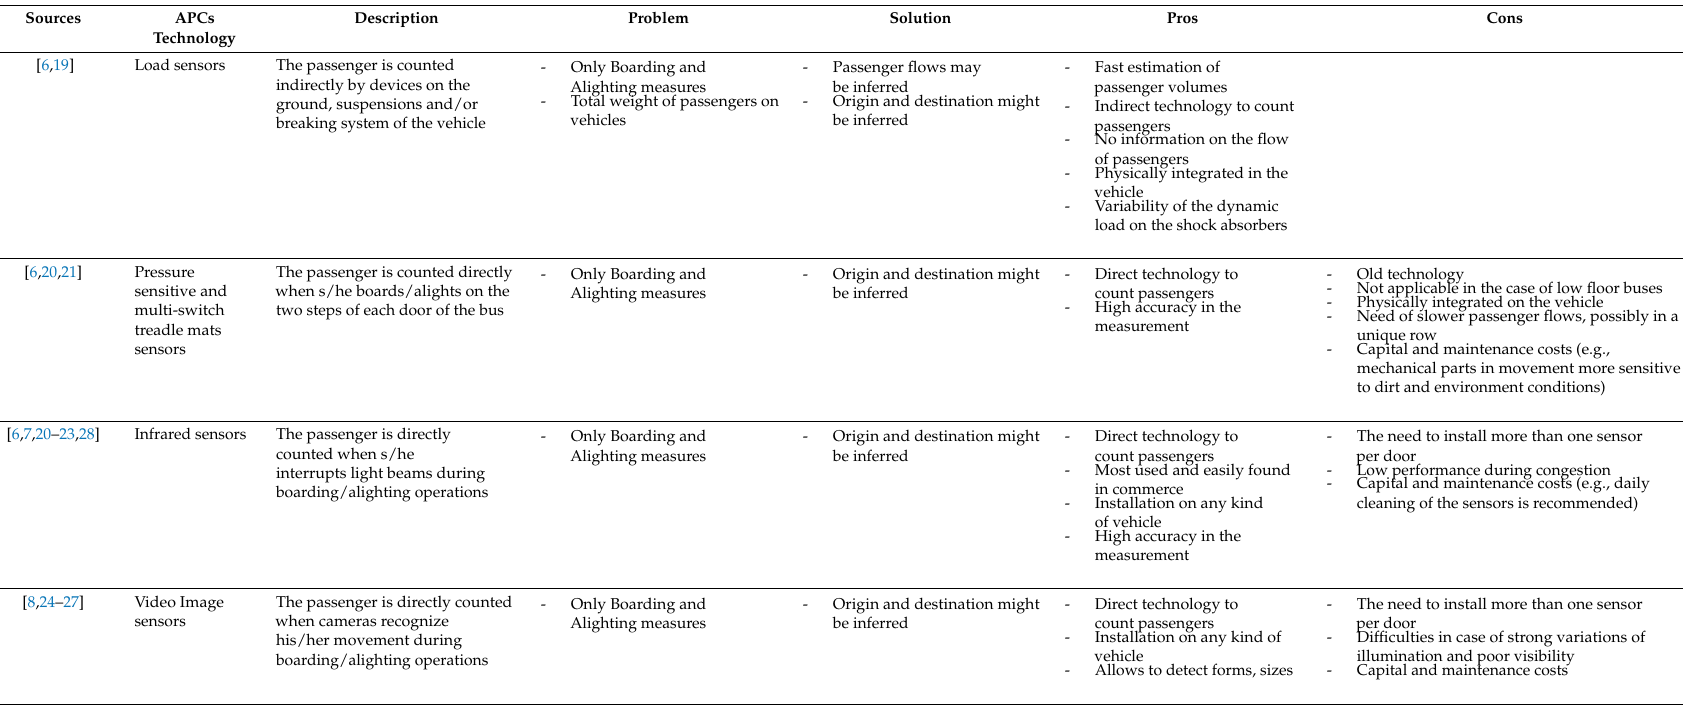
Table 1. Studies on traditional APC technologies (the list of references is representative, but not